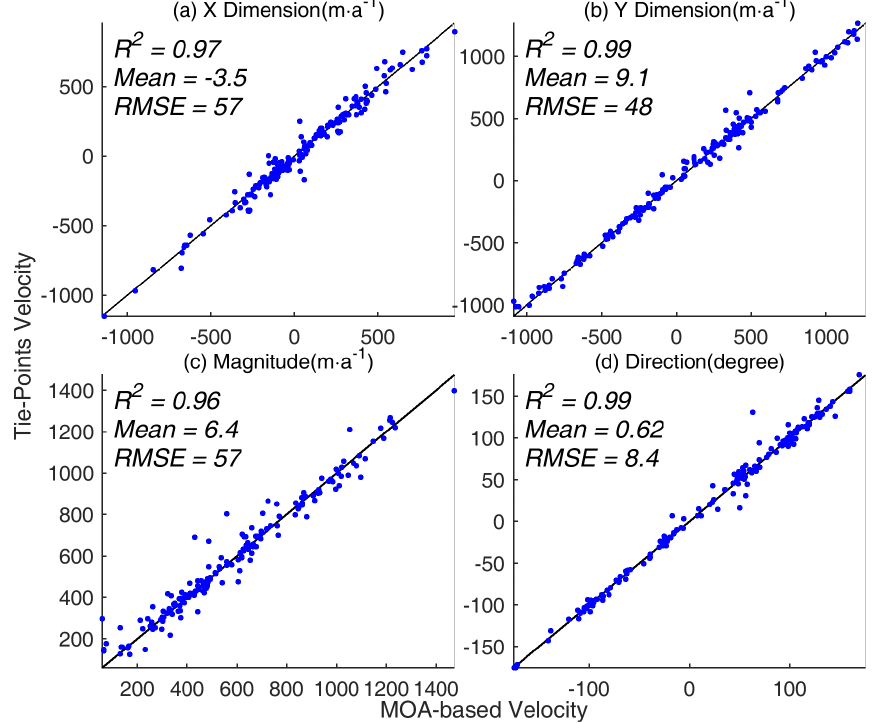
Figure 4. Velocity comparison between MOA-based velocity and manually selected tie points offsets in the ( a ) X dimension, ( b ) Y dimension and ( c ) magnitude, and ( d ) direction